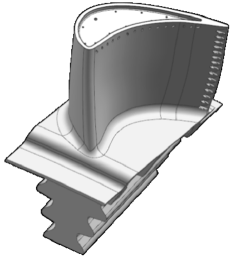
Figure 8. Turbine blade. Figure 8. Turbine